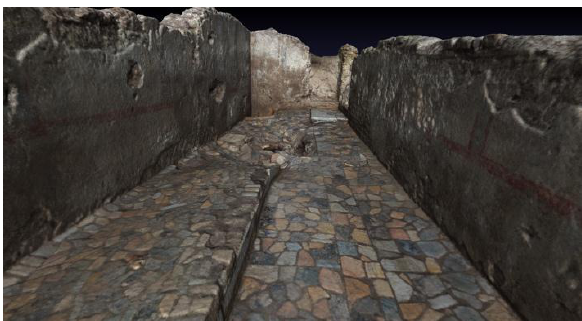
Fig. 7. Visualization Framework